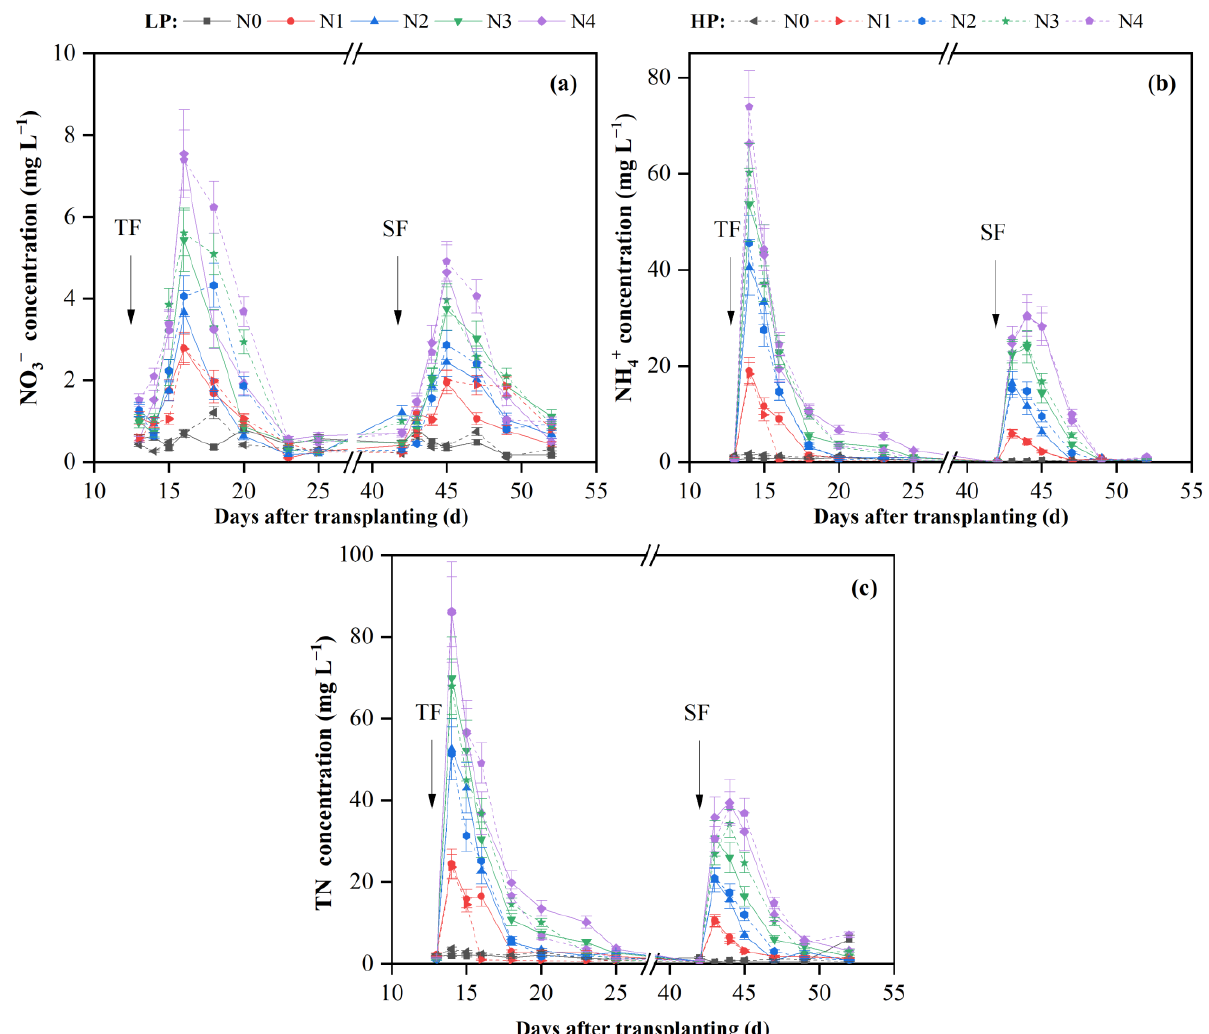
Figure 3. Variations of nitrate-N (NO 3 − -N, ( a )), ammonium-N (NH 4 + -N, ( b )) and total nitrogen (TN, ( c )) concentrations in ponded water collected from different water and N treatments. The arrows denote the application of tillering (TF) and spikelet-developing fertilizer (SF), respectively. The application time of all treatments is the same. LP and HP, i.e., low percolation and high percolation, represent two deep percolation rates controlled by the lysimeters, 3 mm d − 1 and 5 mm d − 1 , respectively. N0~N4 represent 0, 60, 135, 210 and 285 kg N ha − 1 application, respectively.